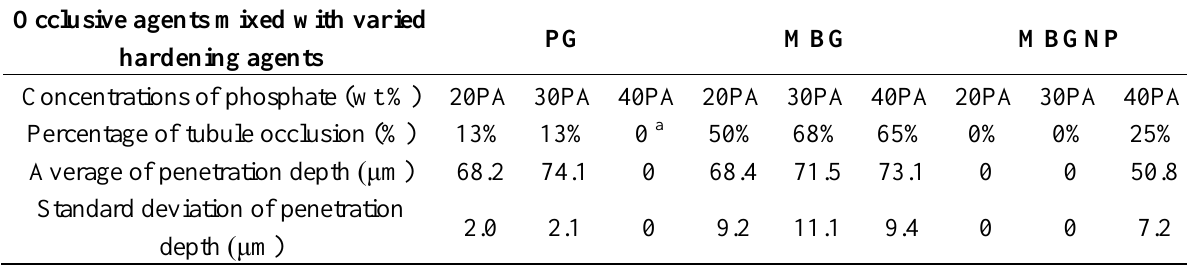
Table 1. The percentage of tubule occlusion and the penetration depth of commercialized PG, synthetic MBG and MBG without phosphorus (MBGNP) based occlusive agents for 10 min mixing with hardening solution ( n =